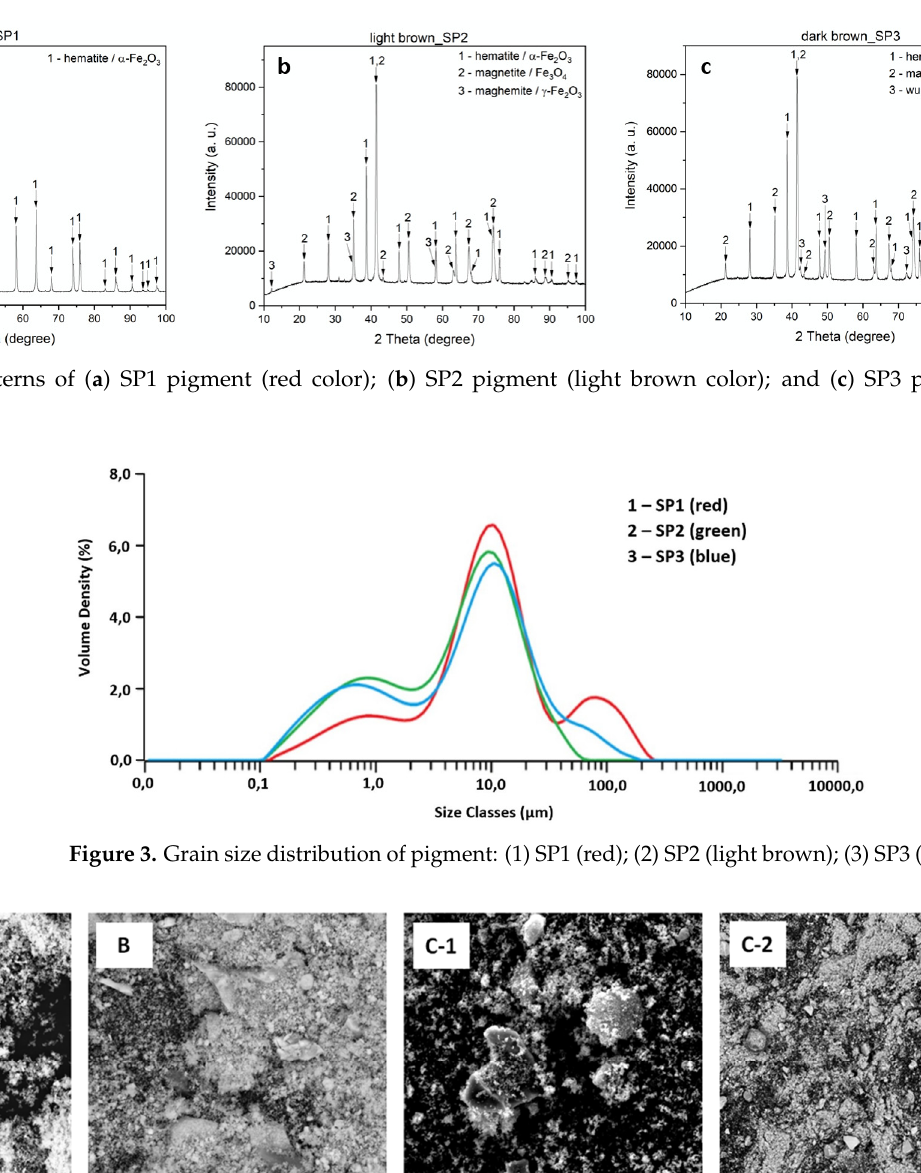
Figure 3. Grain size distribution of pigment: 1) SP1 (red); 2) SP2 (light brown); 3) SP3 (dark brown). Figure 4. SEM images of commercial pigments ( A ) red pigment SP1 with scale 20 µ m; ( B ) light brown pigment SP2 with scale 20 µ m; ( C - 1 ) dark brow pigment SP3 with scale 20 µ m and ( C - 2 ) dark brown pigment SP3 with scale 200 µ m..